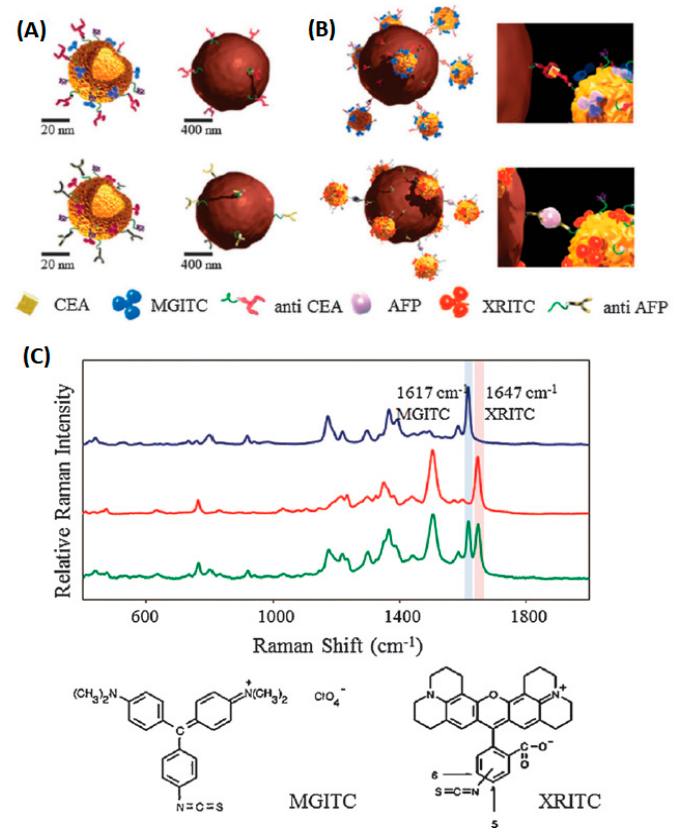
Figure 4. Schematic of the SERS-based duplex immunoassay using hollow gold nanospheres (HGNs) and magnetic beads. ( A ) Conjugation of malachite green isothiocyanates (MGITCs) (Raman reporter) and carcinoembryonic antigen (CEA) antibodies to HGNs (upper left), conjugation of X-rhodamine-5-(and-6)-isothiocyanate (XRITCs) (Raman reporter) and α -fetoprotein (AFP) antibodies to HGNs (upper right), anti-CEA immobilized magnetic beads (lower left), and anti-AFP modified magnetic beads (lower right). ( B ) Formation of sandwich immunocomplexes between HGNs and magnetic beads for CEA and AFP. ( C ) Raman spectra of HGN probes labeled with MGITC (blue), XRITC (red) and a 1:1 mixture of HGNMG and HGNXR (green) (Chon et al.